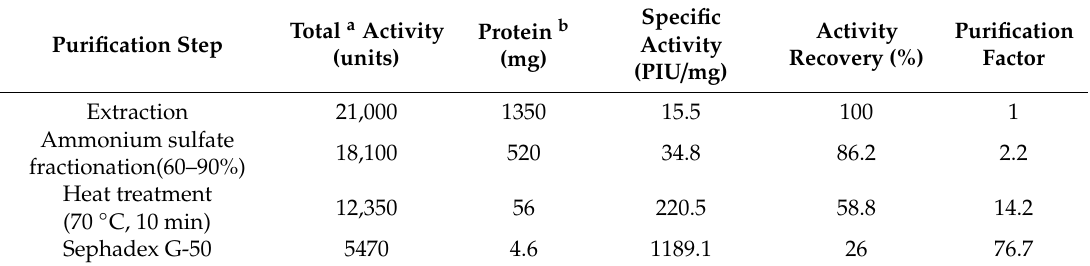
Table 2. Flow sheet of PDInhibitor